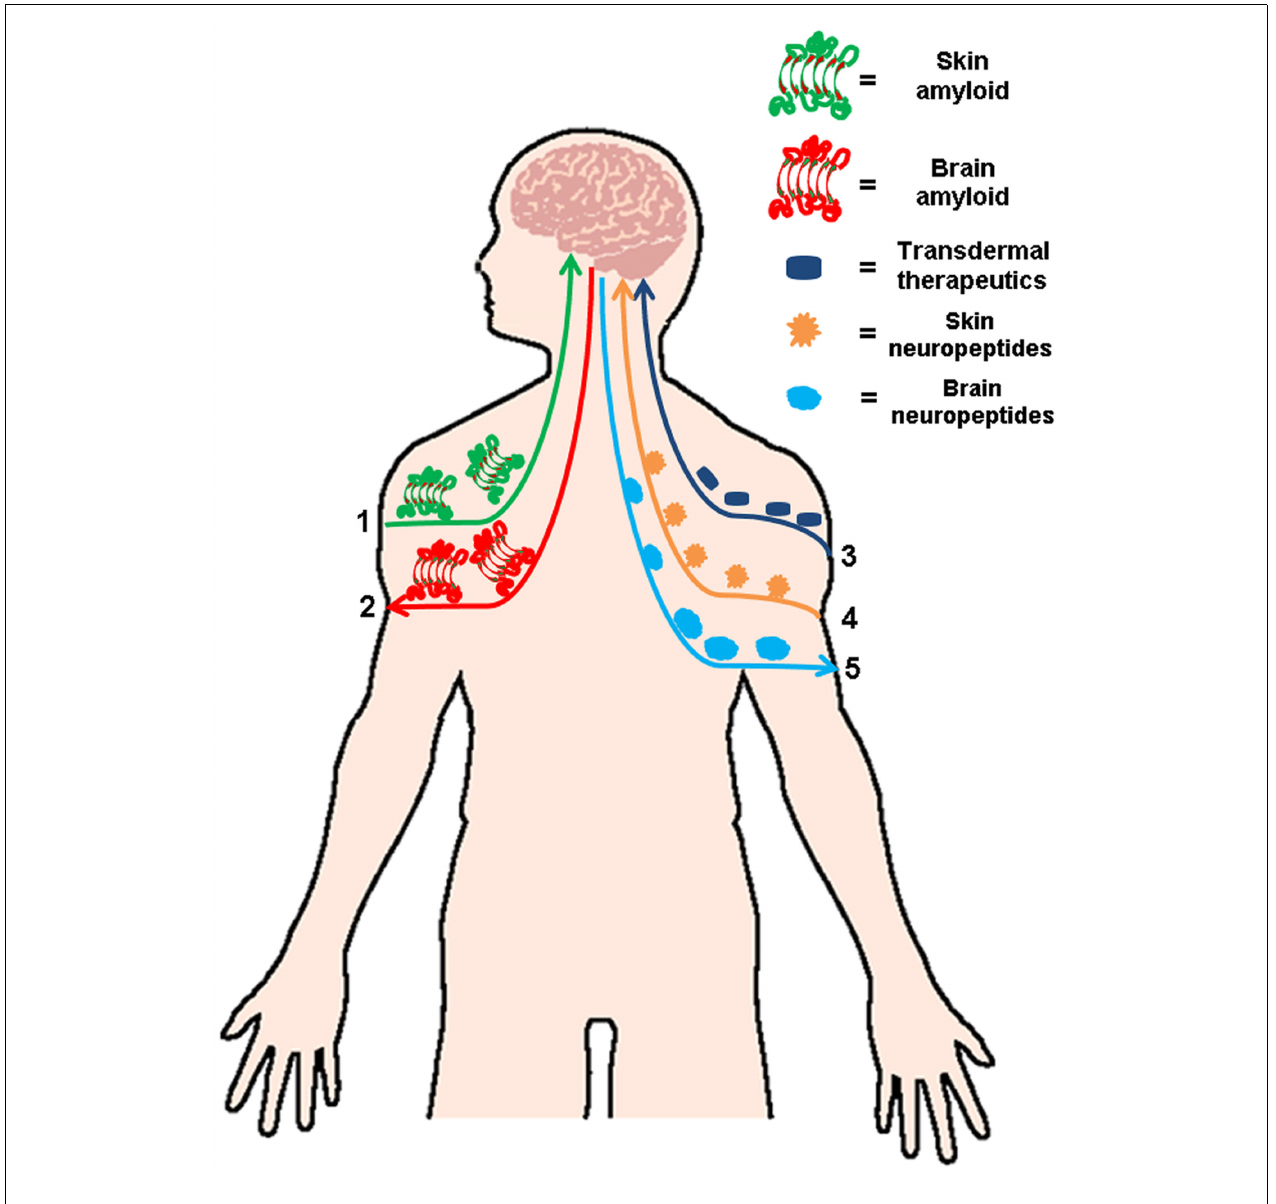
several neurodegenerative amyloidosis via transdermal administration of therapeutics (3).The skin–brain connection not only involved amyloid treatment and formation, but also has an important relevance in several dermatologic conditions linked to neuroimmunological stress, in which an increase of neuropeptides in the skin (4) or the brain (5) has been